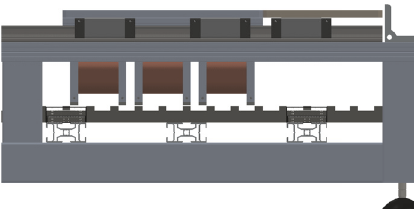
Figure 3: Front view of magnetic circuit parts at P1 (poles of phase b aligned with the secondary teeth).